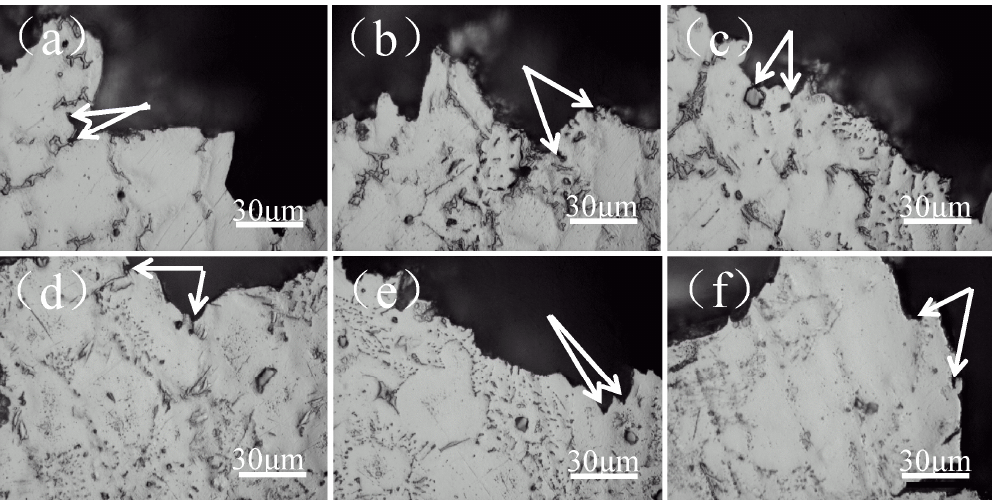
Figure 7. Metallographic microstructure near the fracture of as-cast Mg-11Gd-2Y-1Zn-xAl alloys. ( a ) x = 0; ( b ) x = 1; ( c ) x = 2; ( d ) x = 3; ( e ) x = 4; ( f ) x = 5.